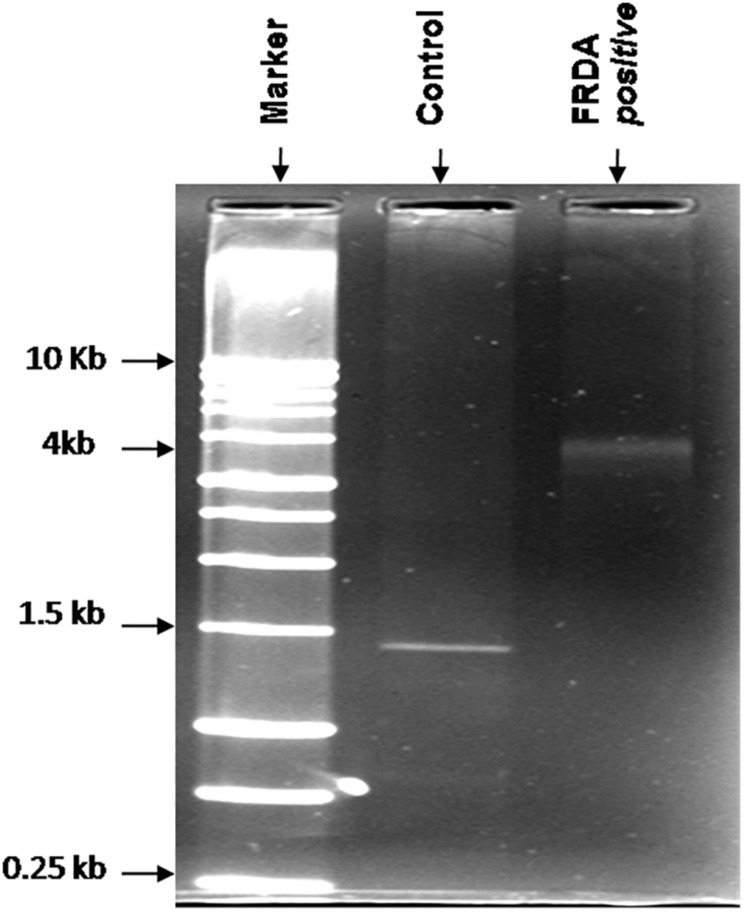
Representative image of the agarose gel of the PCR products obtained from FRDA patients and healthy controls. Lane 1, 1-kb DNA ladder; Lane 3, homozygous FRDA patient with 4-kb bands; and Lane 2, healthy control.